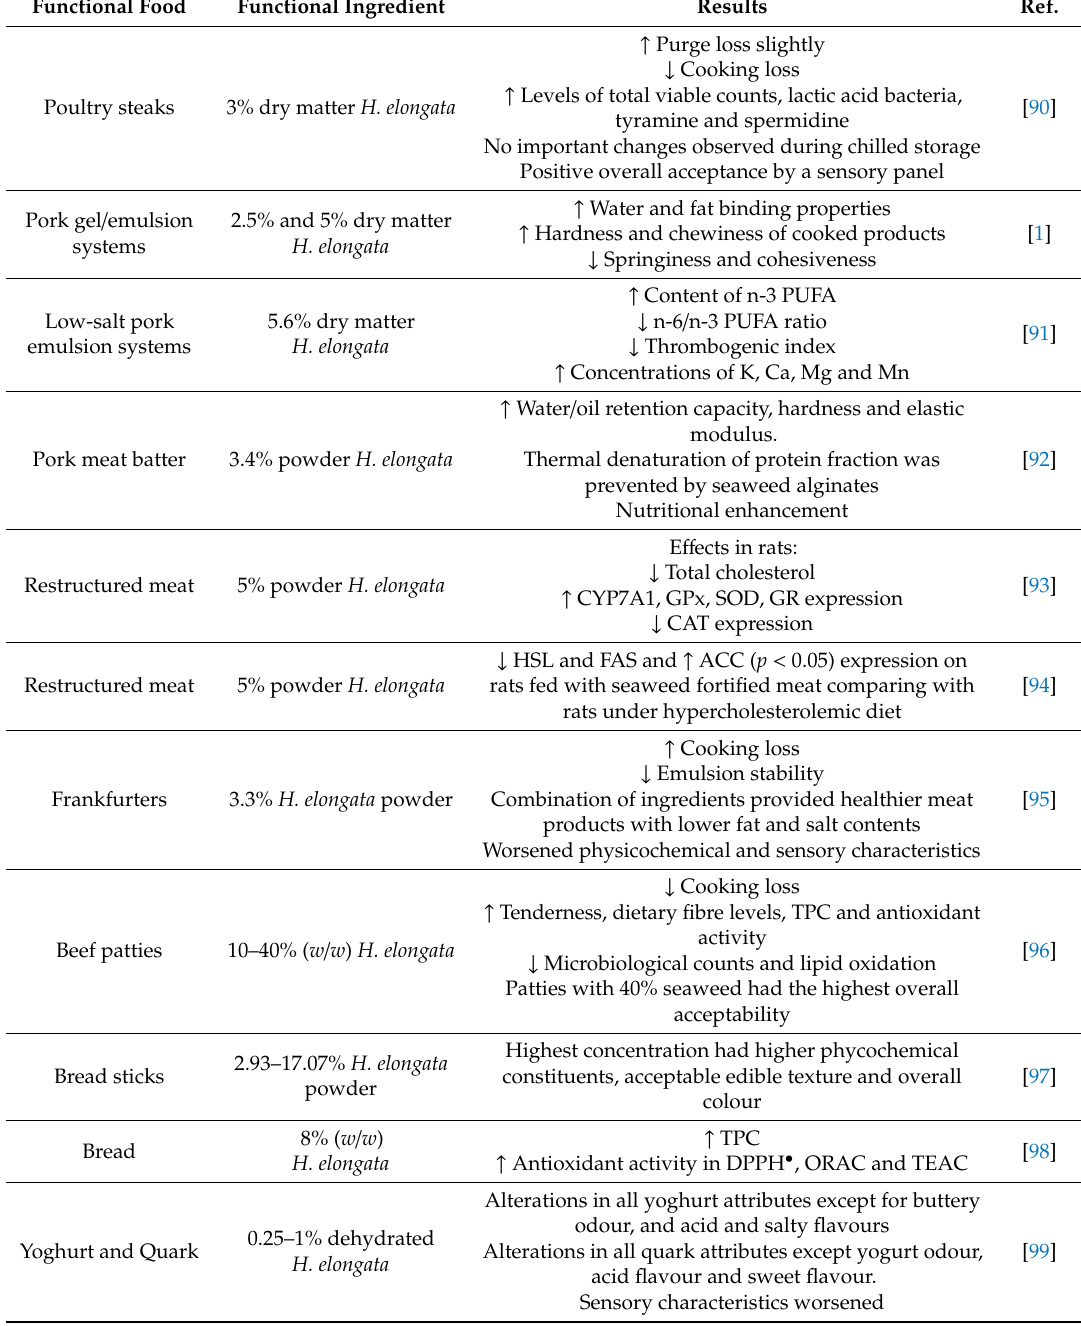
Table 2. Selected studies reporting the e ff ects of the incorporation of H. elongata or isolates as ingredients in di ff erent food